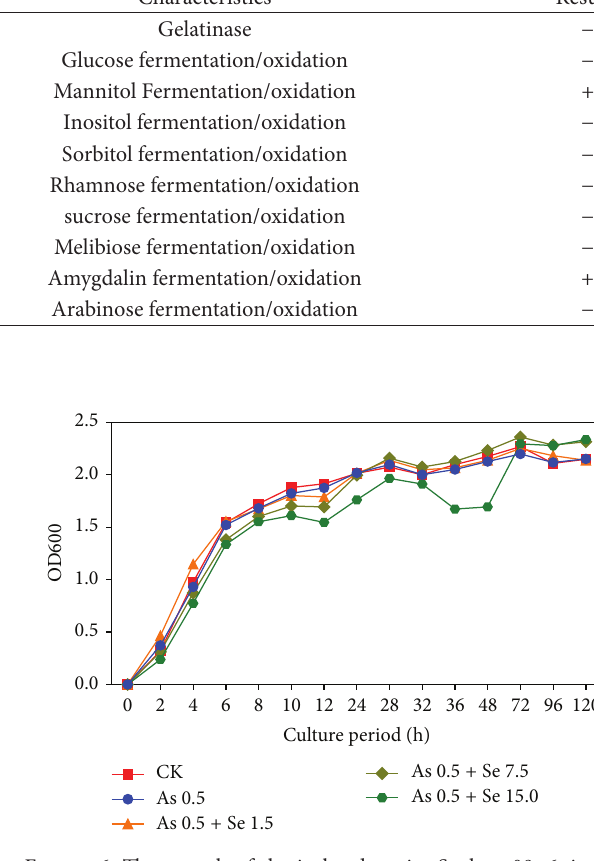
Figure 6: The growth of the isolated strain, Suzhou 08+6, in the culture medium with different concentration of Se and As. One control group and four experimental groups with 0.5mg As L −1 and different concentration of Se (0, 1.5 mg SeL −1 , 7.5 mgSeL −1 , and 15.0 mg SeL −1 ) in the culture medium ( 𝑛 = 5